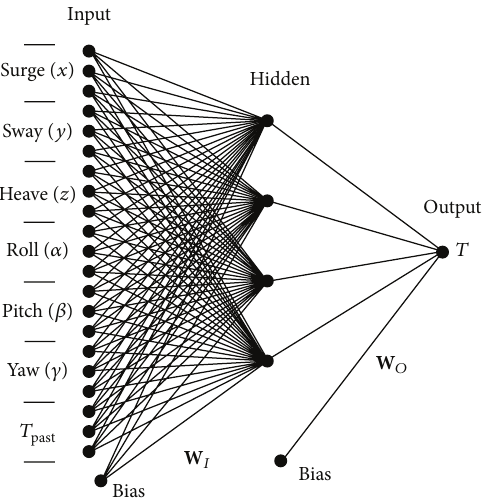
Figure 1: Sketch of artificial neural network for predicting top tension force in mooring